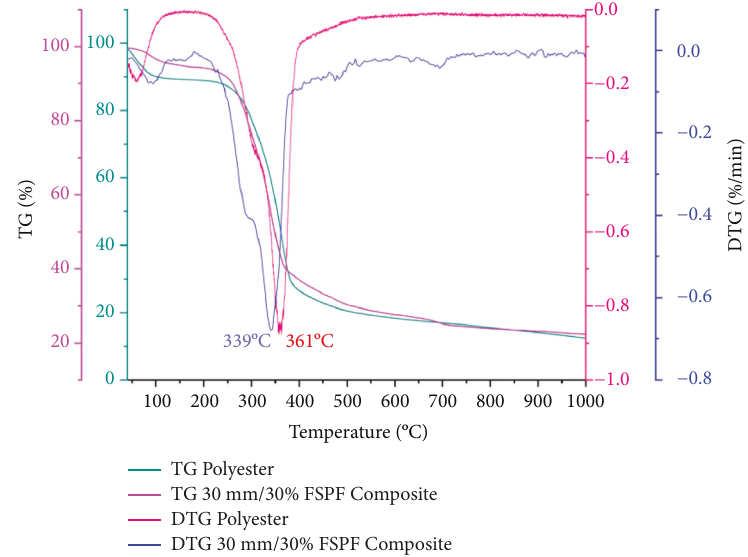
Figure 6: TG and DTG curves of the polyester and FSPF/polyester (30mm length and 30wt.% fiber) composite.